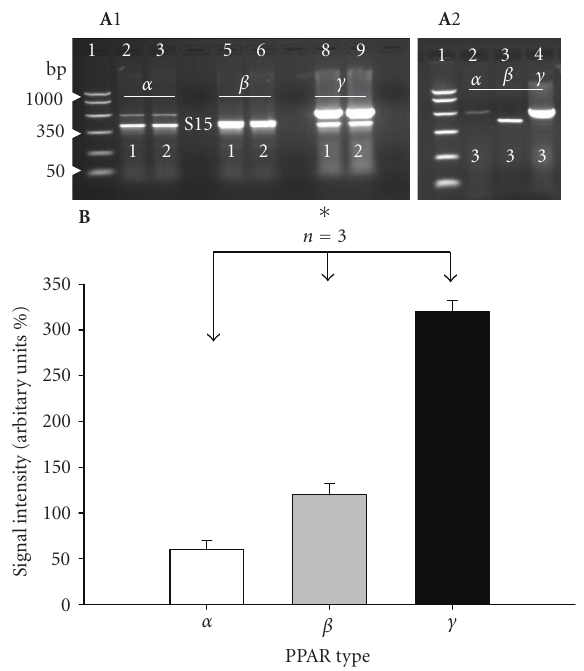
Figure 1: (A1) and (A2) RT-PCR amplification of three PPARs ( α , β , and γ ) from the body of the penis of three (1, 2, and 3) normal adult (120 days) control rats. (A1) Shows coamplification of PPARs ( α , β , and γ (upper bands) and S15 (small ribosomal subunit protein as housekeeping gene, lower bands) in two representative rats (1 and 2). PCR markers were included in lane 1. Expected band sizes for S-15, PPAR α , PPAR β , and PPAR γ were 361, 492, 390, and 533 bp, respectively. Identities of amplicons were further confirmed by sequence analysis (see Section 2). Note that the ampilicons for PPAR β and S15 in lane 5 and 6 were overlapped (compare run for PPAR α , PPAR β , and PPAR γ without S15 shown for rat 3 in (A2). In all rats note the predominant expression of PPAR γ . 15 μ L PCR products were loaded per each lane. (B) Graphic representation of signal intensity for PPARs showing predominant expression of PPAR γ . Transcript levels were normalized to the levels of S15 housekeeping gene. To calculate the intensity for PPAR β the mean intensity of S-15 in lanes 2, 3, 8, and 9 in Figure (A1) was subtracted from the combined intensity of PPAR β + S15 in lanes 5 and 6 to obtain the intensity of penile PPAR β for rat 1 and 2, respectively. ∗ P < . 05.